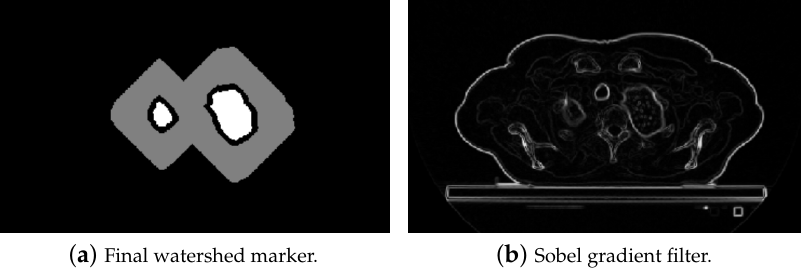
Figure 11. Sobel filter application in the watershed algorithm.